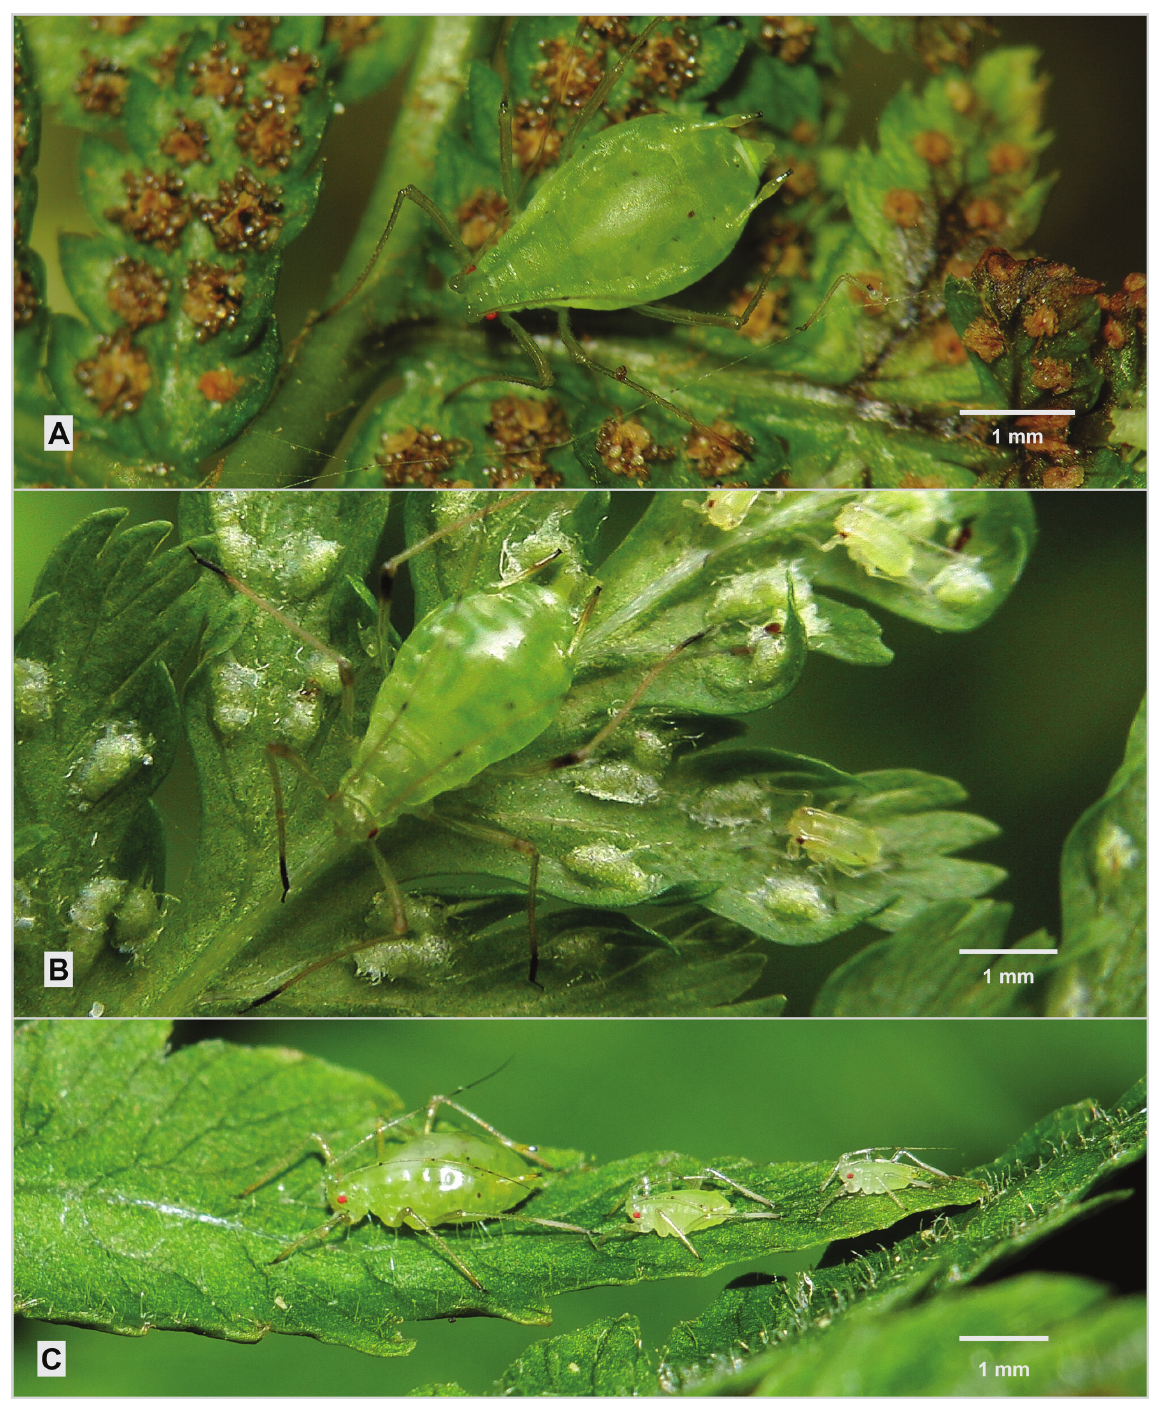
Fig. 34. Amphorophora ampullata buckton, 1876. A . Aptera on Dryopteris carthusiana . B–C . Apterae and juveniles on Athyrium filix-femina (b) and Matteuccia struthiopteris (C), aptera in C